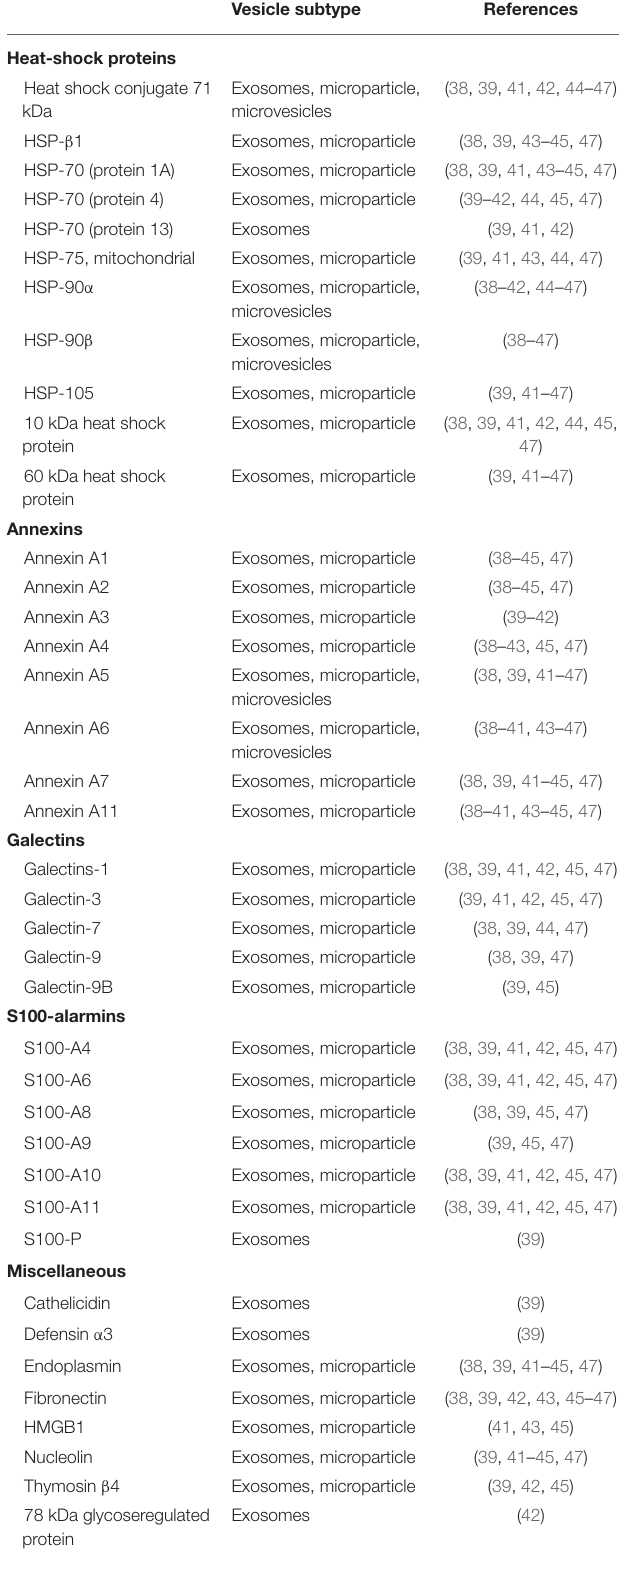
TABLE 1 | List of alarmins found by proteomic analysis of monocyte and macrophage-derived